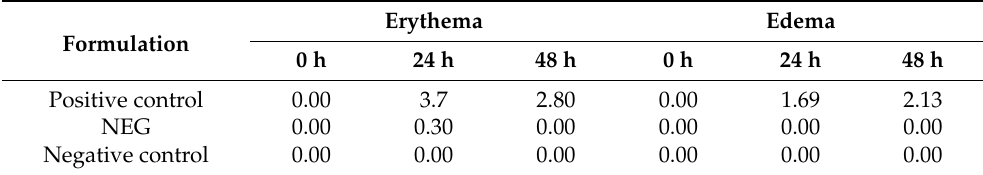
Table 5. Goat buccal mucosal and skin irritation